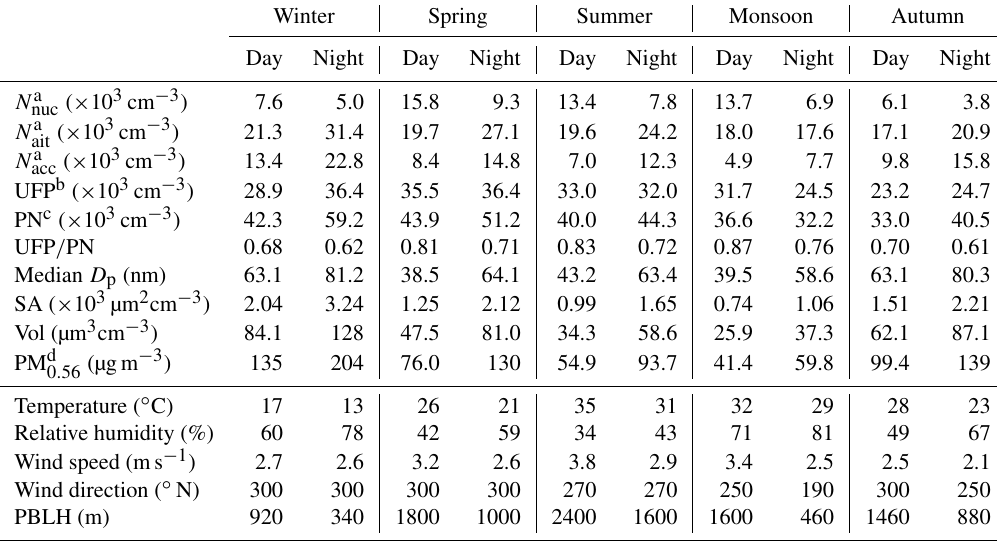
Figure 5. Stacked average absolute and fractional diurnal profiles of N nuc ( D p < 25nm), N ait (25 < D p < 100nm), and N acc ( D p > 100nm) by season. These averages are based on the observed SMPS data (12 < D p < 560nm). We also include seasonal average concentrations for the PM 2 . 5 concentrations from a regulatory monitor (DPCC; Rama Krishna Puram, 3km from our site) and mass concentrations estimated from the observed SMPS data (PM 0 . 56 ). Table 1. Day and night summary of observations derived from the particle size distributions (PSDs) and meteorological parameters. Arith- metic mean was used for all species and parameters, except wind direction (for which we used the median to estimate its central tendency). Winter